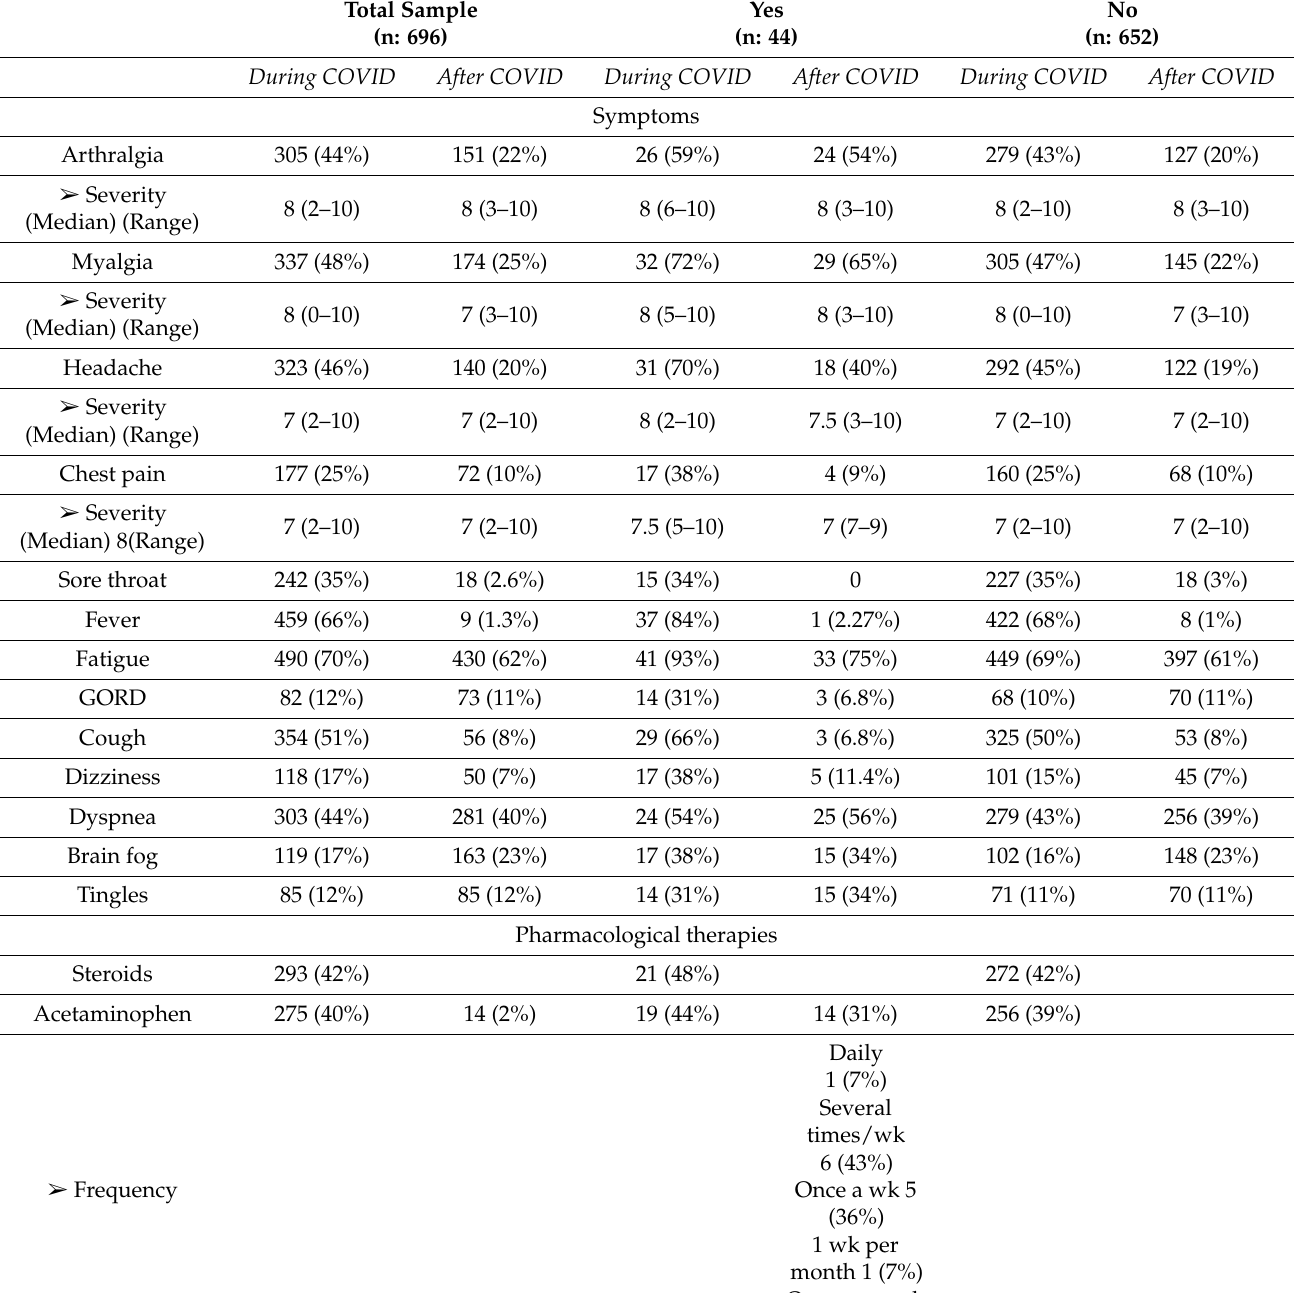
Table 2. Symptoms during and after COVID-19 and utilization of analgesic therapies in the groups of interest (YES: those who continued taking analgesics in the post-acute phase; NO: those who did